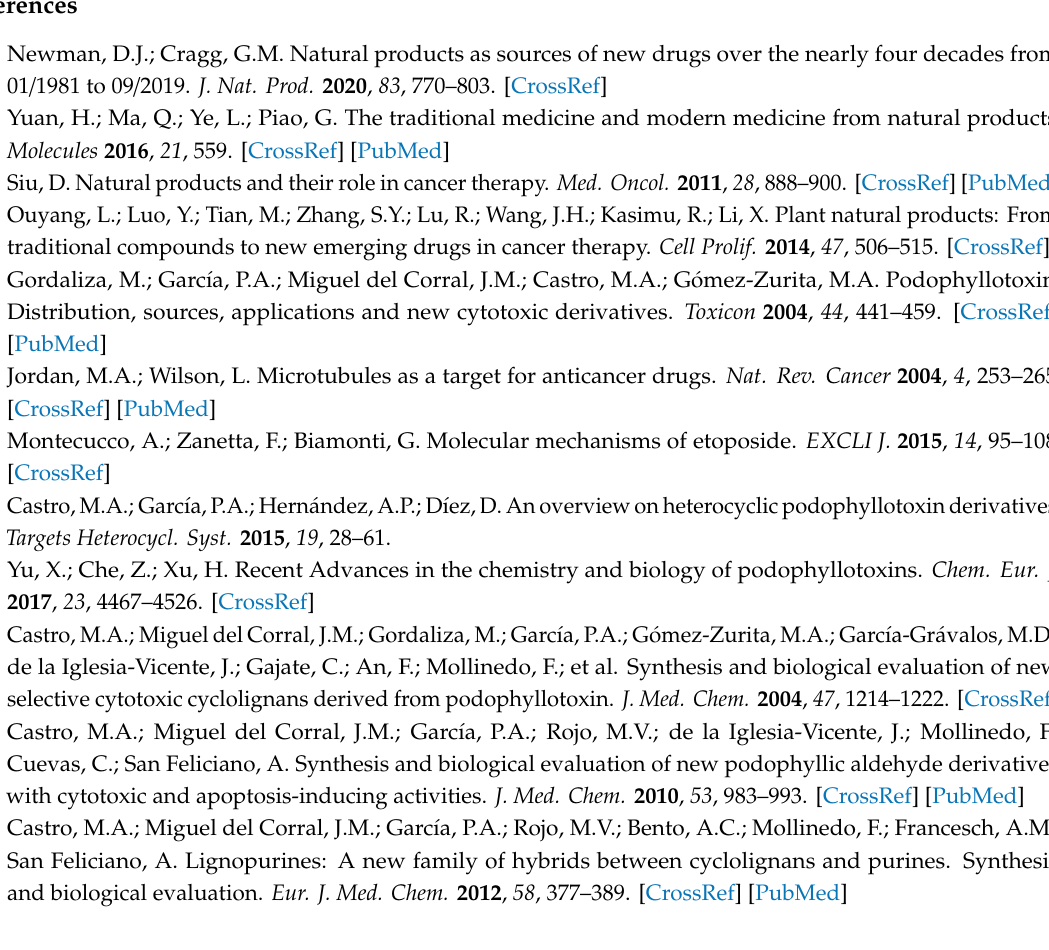
compound 3 . Table S4: 1 H NMR data for compound 4 . Figure S1: 1 H and 13 C NMR spectra for compound 3 (CDCl 3 ). Figure S2: 1 H and 13 C NMR spectra for compound 4 (CDCl 3